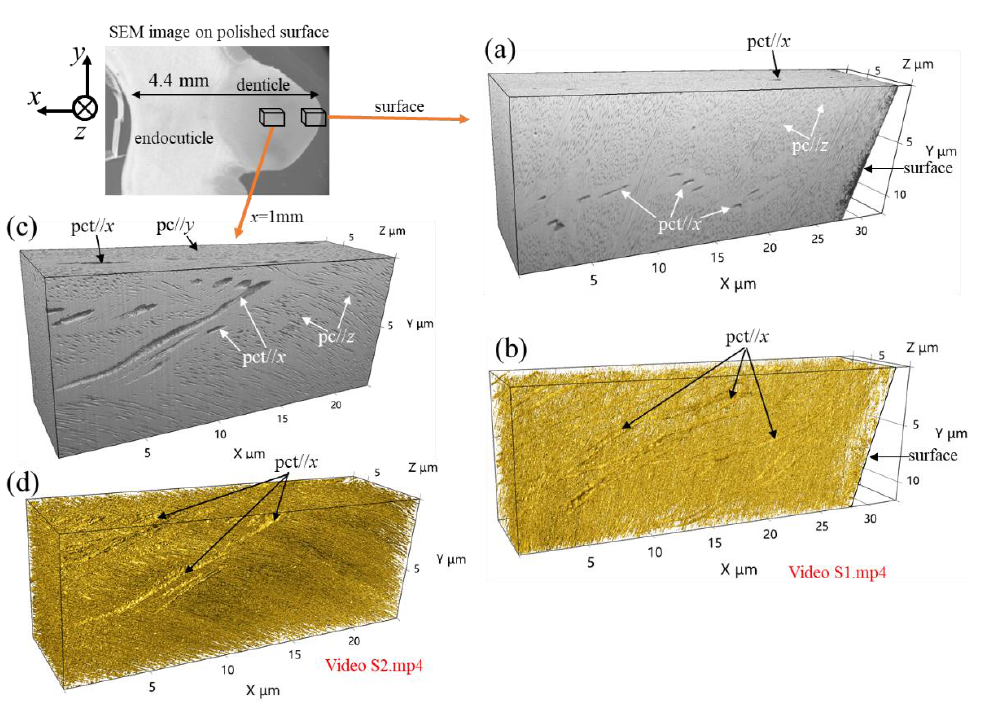
Figure 2. Three-dimensional (3D) microstructure in ( a , b ) surface and ( c , d ) x = 1 mm of the denticle. Each image was recorded with a slice pitch of 15 nm in the z -direction via a focused ion beam – SEM system, and 3D images were reconstructed using visualization software from serial-sectioning images in the x - y plane. ( a , c ) 3D images reconstructed through the software without any special image processing and ( b , d ) 3D images were reconstructed by coloring the edges of the high-brightness part with gold through the software.